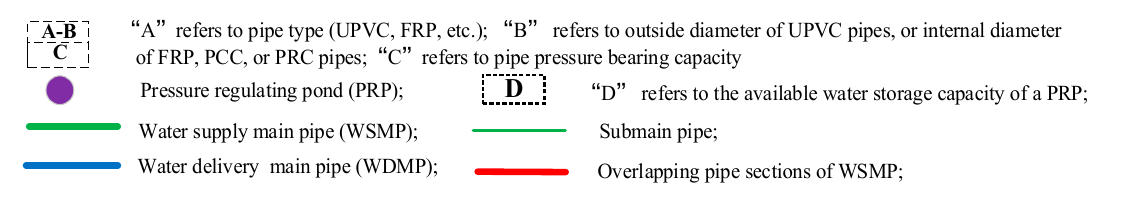
Figure 5. Design schemes with the ( a ) empirical method and ( b , c , d ) proposed methods for Case